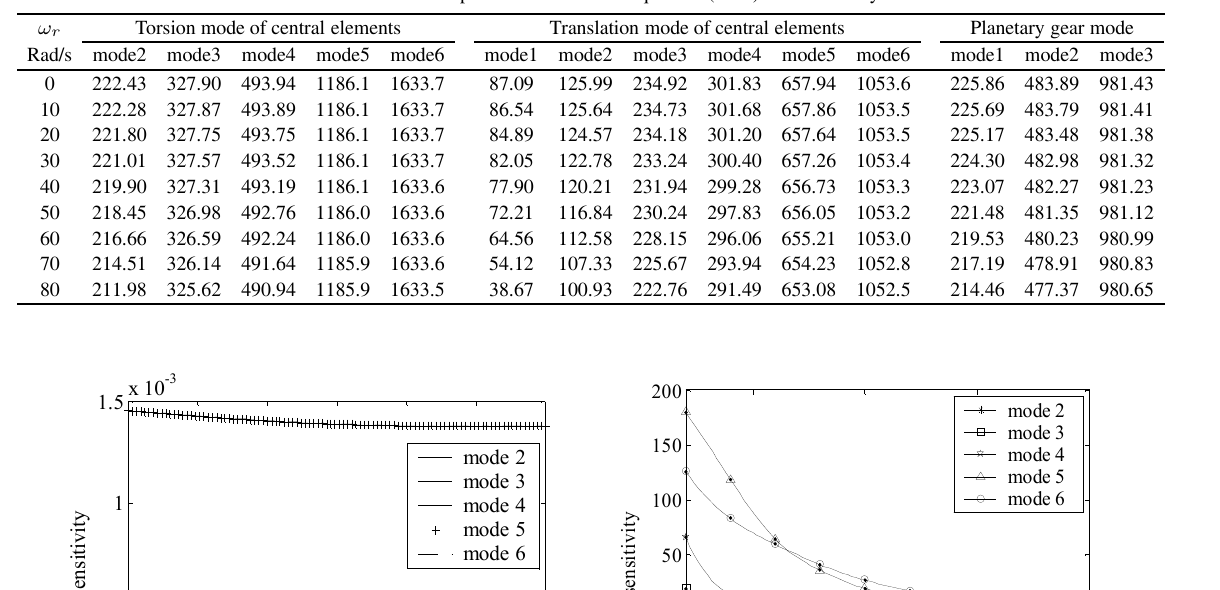
Table 5 The effects of the rotor speed on the natural frequencies(rad/s) of the drive system